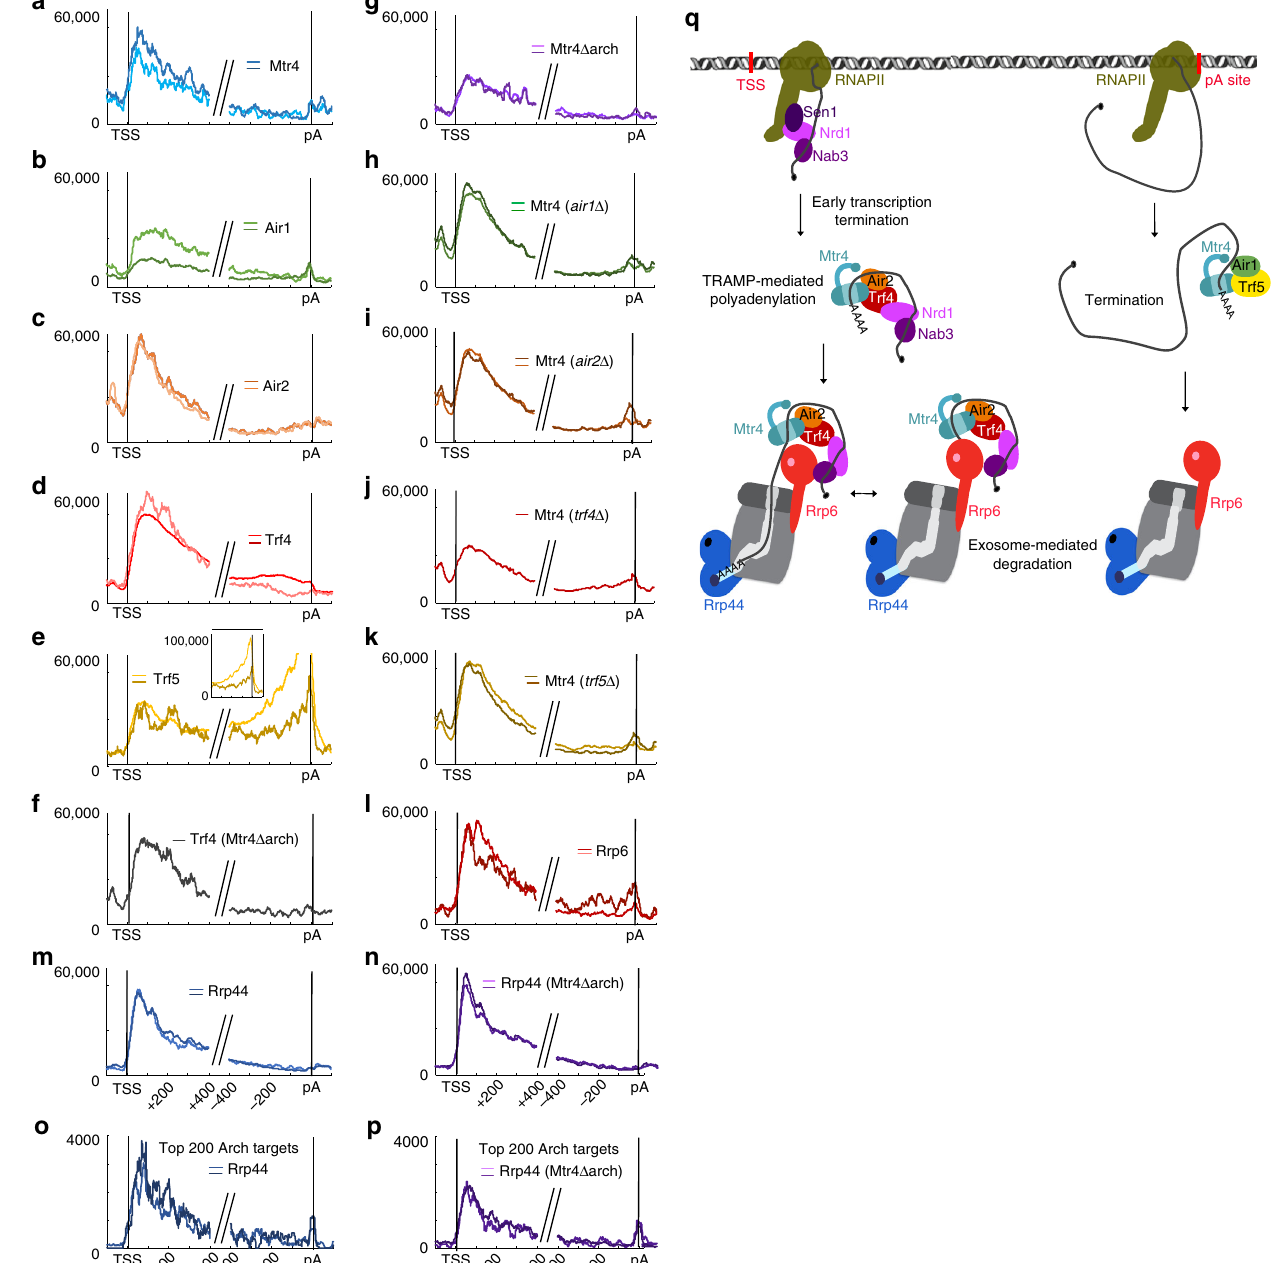
Fig. 4 Metagene analyses of TRAMP components across protein-coding genes. Binding by RNA surveillance and degradation factors is strongly enriched close to the TSS on protein-coding genes. a – n Distribution of individual components indicated, across all mRNAs longer than 500 nt. Each panel shows the hit density, normalized to millions reads mapped to mRNAs. The two lines in each panel represent results from independent CRAC experiments. Reads were aligned with transcription start sites (TSS) and polyadenylation sites (pA). o – p Distribution of Rrp44 in strains expressing Mtr4 or Mtr4 Δ arch across the 200 mRNAs showing the greatest dependence on the arch for Mtr4 recruitment. Each panel shows the hit density, normalized to millions of reads mapped to mRNA, for all genes longer than 500 nt. The two lines in each panel represent results from independent CRAC experiments. Reads were aligned with transcription start sites (TSS) and polyadenylation sites (pA). q Model representing proposed recruitment pathways. Close to the TSS, Nrd1 – Nab3 – Sen1-mediated early transcription generate TSS-proximal ncRNAs and recruits TRAMP4-2 through Trf4 and interactions involving the